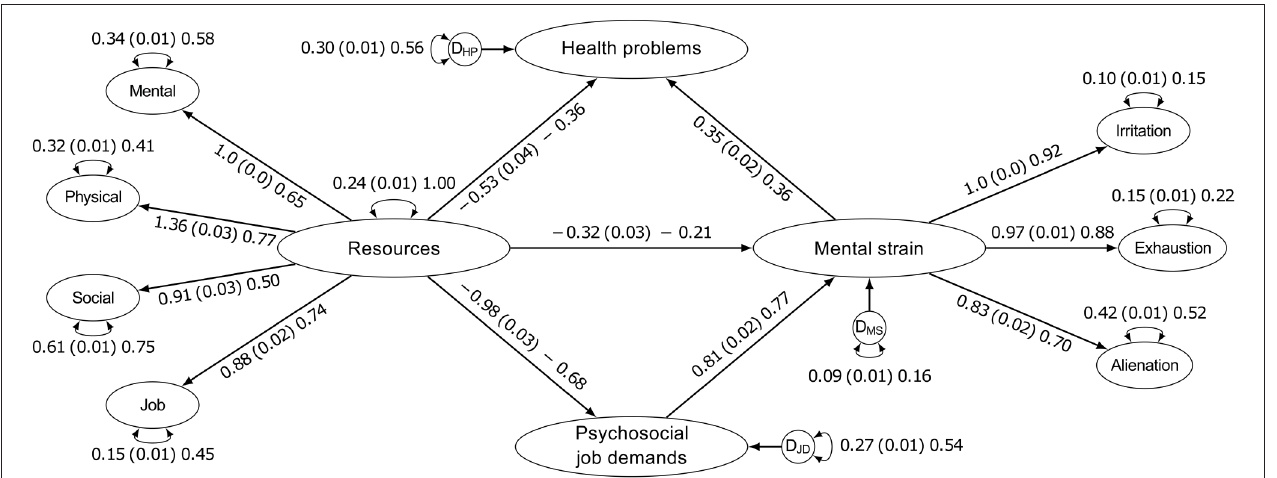
the two occupational groups: blue collar worker ( N = 2529) and white collar worker (98.5%)/entrepreneur (0.3%)/liberal profession (1.2%) ( N = 7007). We applied a sequential